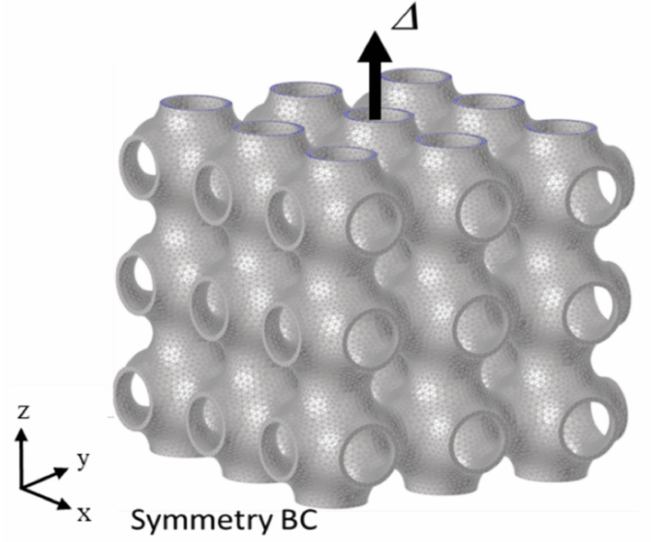
Figure 8. FE model of P-S pertaining to ρ = 10% with uniaxial loading and symmetric